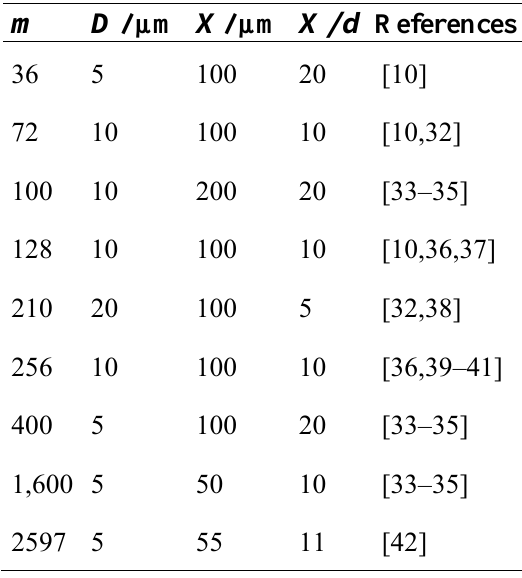
Table 1. Geometric features of ultramicroelectrode arrays of different geometries fabricated by